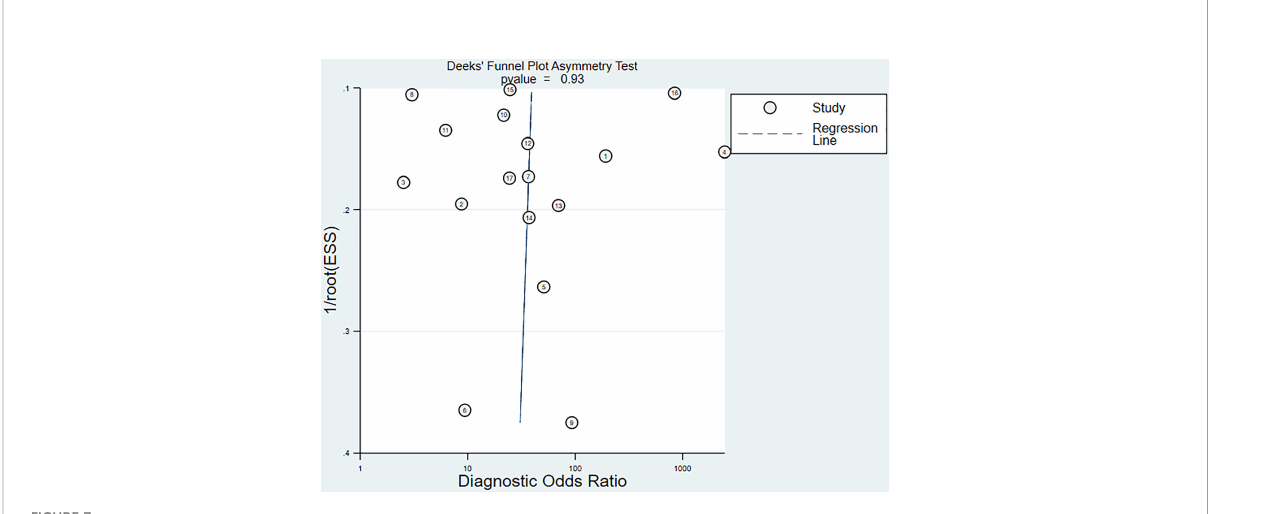
FIGURE 7 The Deeks ’ funnel plot for assessing the publication